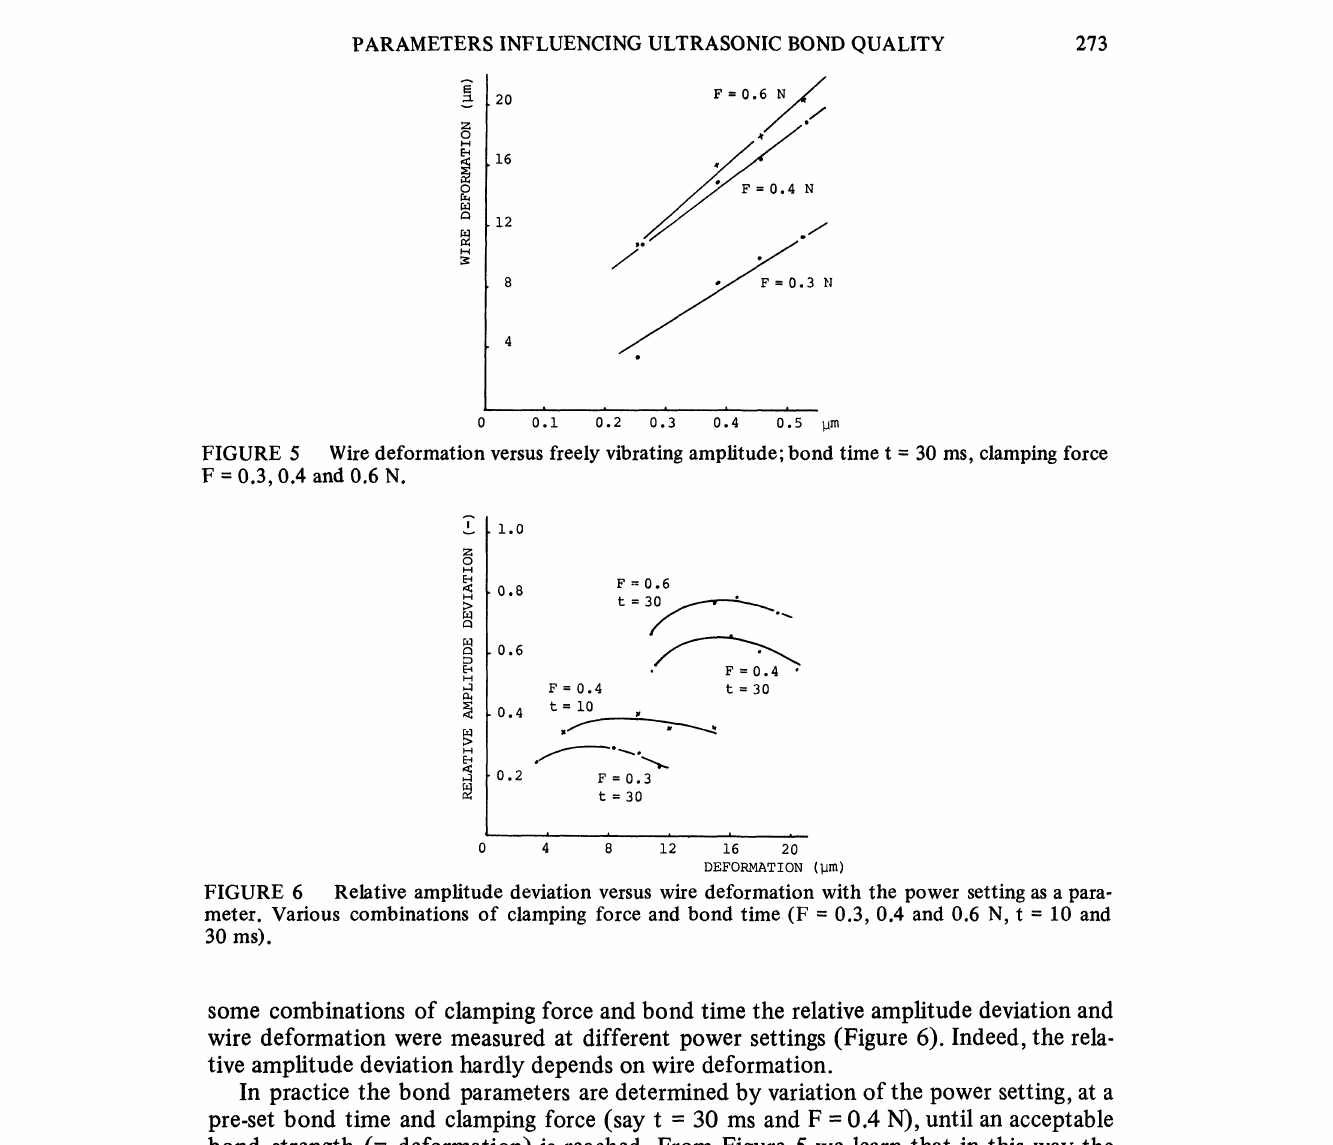
Relative amplitude deviation versus wire deformation with the power setting as a para- meter. Various combinations of clamping force and bond time (F 0.3, 0.4 and 0.6 N, 10 and 30